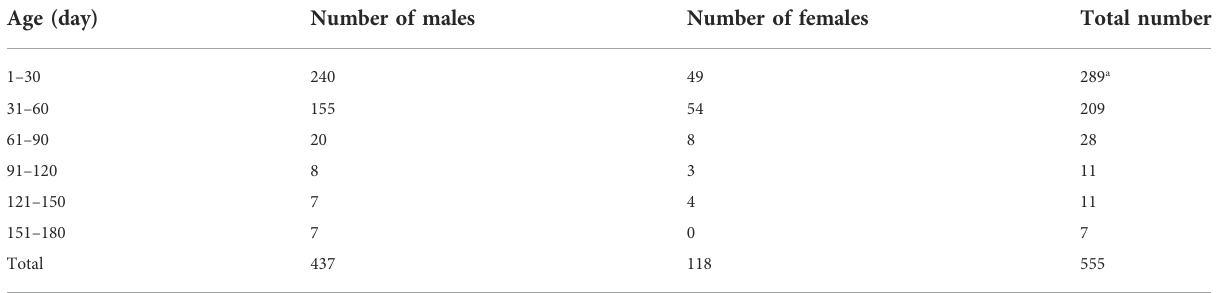
TABLE 1 Age of infants at the time of sampling for the diagnostic testing of G6PD de fi ciency. Age (day)